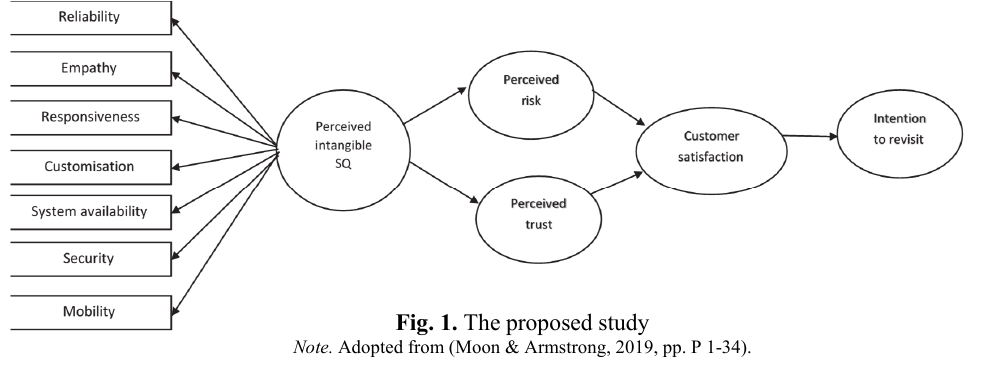
Fig. 1. The proposed study Note. Adopted from (Moon & Armstrong, 2019, pp. P